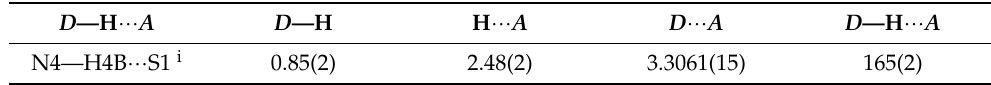
Table 9. Hydrogen-bond geometry (Å, ◦ ) for 7 .